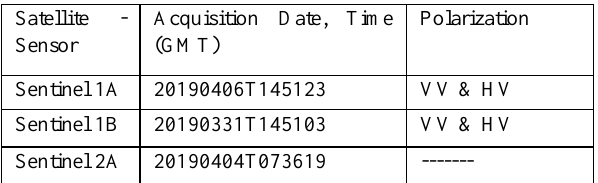
Table 1. Sentinel-1 mission data